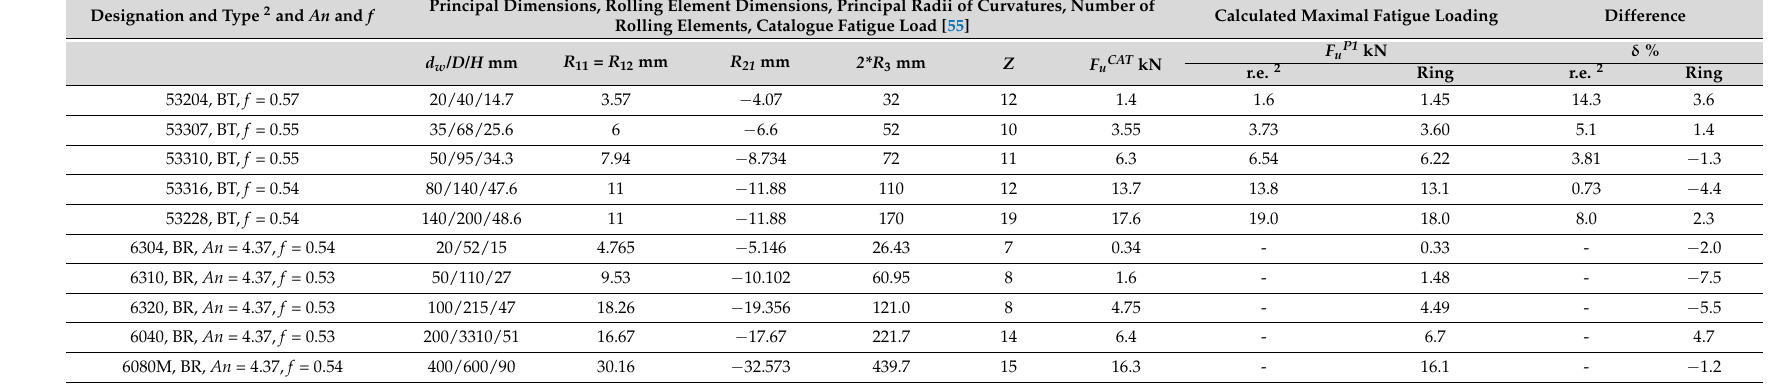
Table 3. Results of fatigue life calculations for ball bearings under an N 10% reliability condition concerning one million bearing